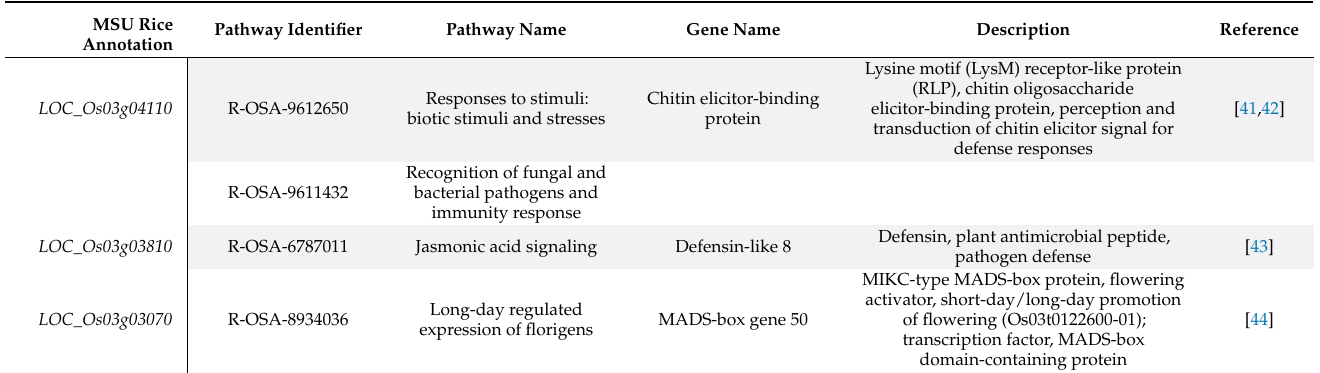
Table 5. List of candidate genes identified from the major QTL on chromosome 3 overlapping for SB, BPB, and